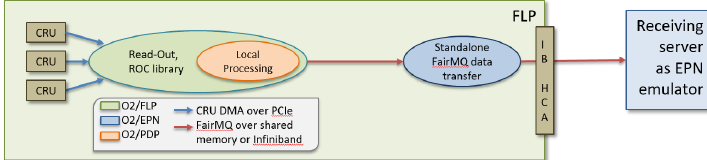
Figure 2. Realistic FLP data flow, from CRU to NIC card, including data processing. O2 FLP / EPN / PDP are the di ff erent project groups that develop software running on the FLP to handle the data stream.